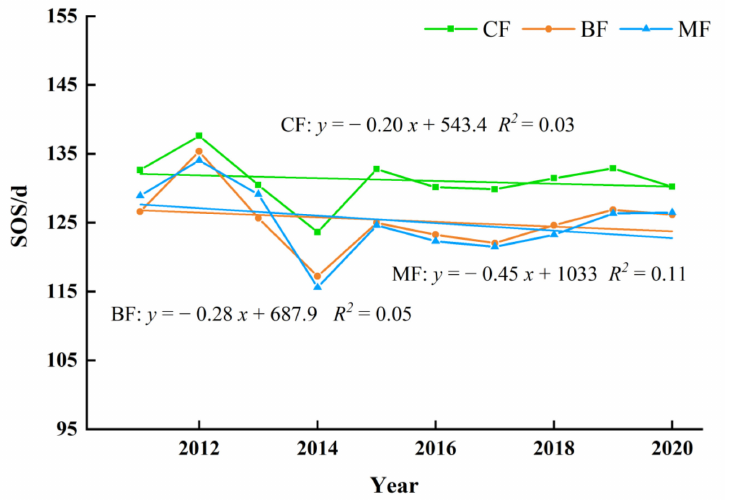
Figure 14. The interannual changes of SOS in different forest types from 2011 to